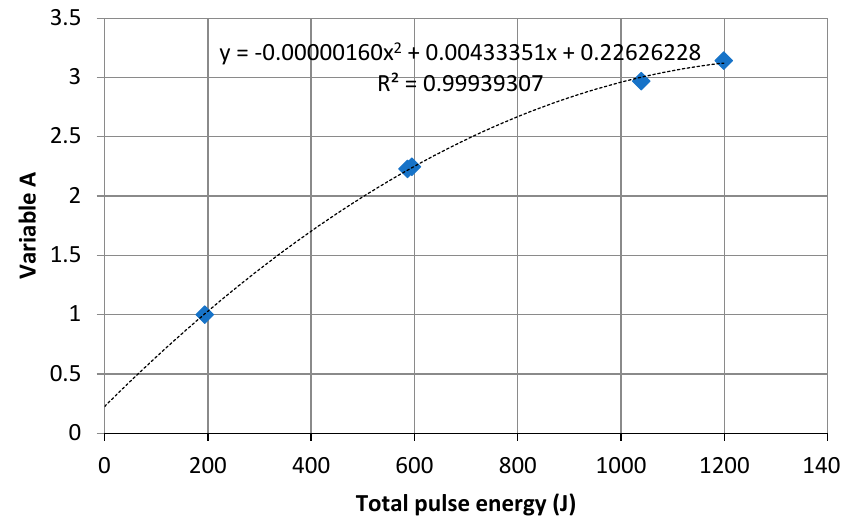
Figure 3. Variable A variation against total thermal pulse energy.